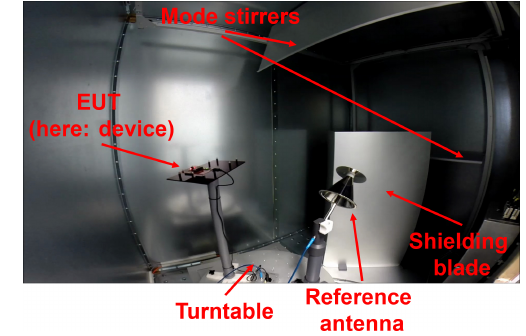
Figure 12. Photo inside a RC. (in order to capture the whole interior of the RC, the photo was taken using a fisheye lens and is therefore distorted at the